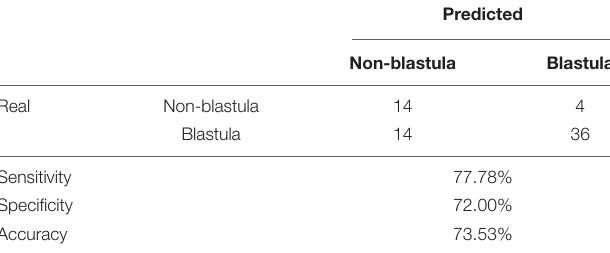
TABLE 1 | Performance of the deep learning